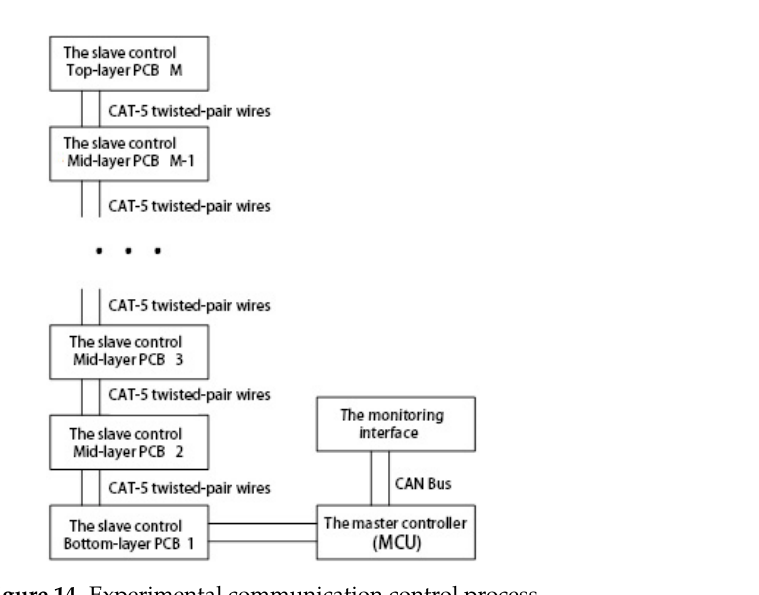
Figure 14. Experimental communication control